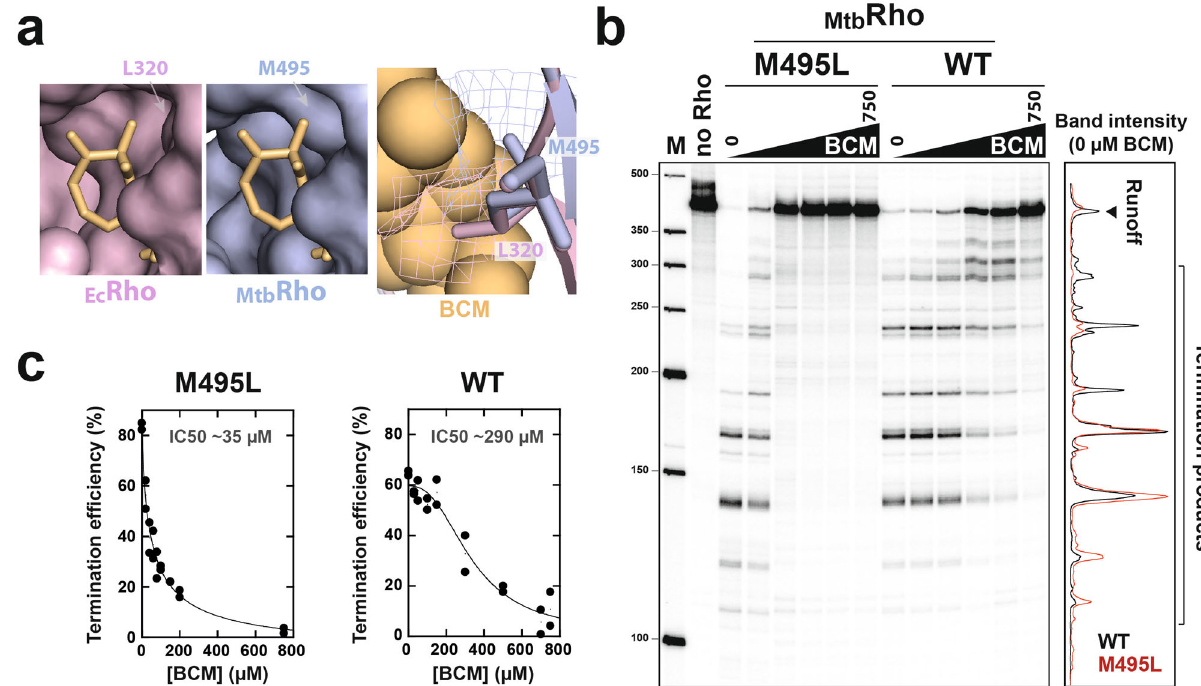
Fig. 3 The Mtb Met495 side-chain confers BCM resistance to Mtb Rho. a The BCM binding pockets of Ec Rho (PDB 1PV4) and Mtb Rho (this work). BCM has been fi tted into the pockets by structural alignment with BCM-bound Ec Rho (PDB 1XPO). Ec Rho (left panel) or Mtb Rho (middle panel) are shown alone in full surface representation. In the right panel, both structures are superimposed with the surfaces of the Mtb M495 and Ec L320 residues in mesh representation; BCM (sphere representation) only invades the mesh surface of Mtb M495, illustrating a potential steric clash. b The M495L mutation sensitizes Mtb Rho to BCM. A representative PAGE gel shows the effects of increasing concentrations of BCM (0 – 750 µ M) on the transcription termination activities of the WT fi les for the WT (black) and M495L (red) proteins in absence of BCM (lanes 0). c IC50 Mtb Rho and M495L mutant. The graph compares the gel lane pro graphs deduced from n = 2 independent transcription termination